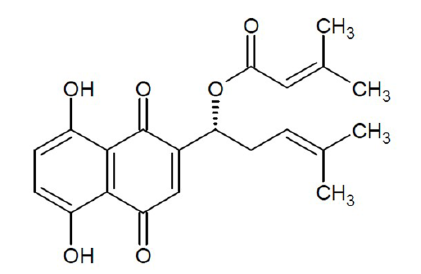
Figure 1. Molecular structure of β , β -dimethylacrylshikonin